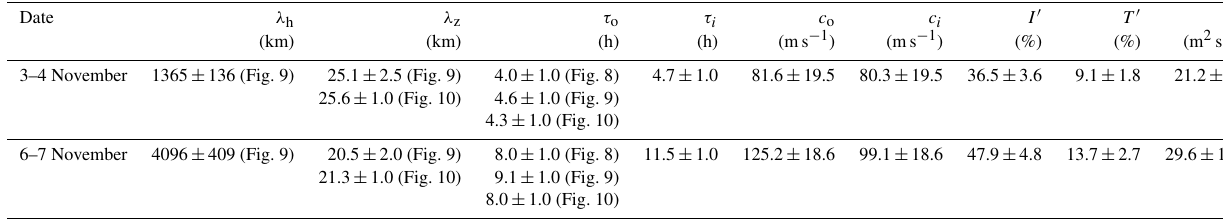
Table 3. Estimated features of the large-scale waves observed in the airglow and meteor radar wind